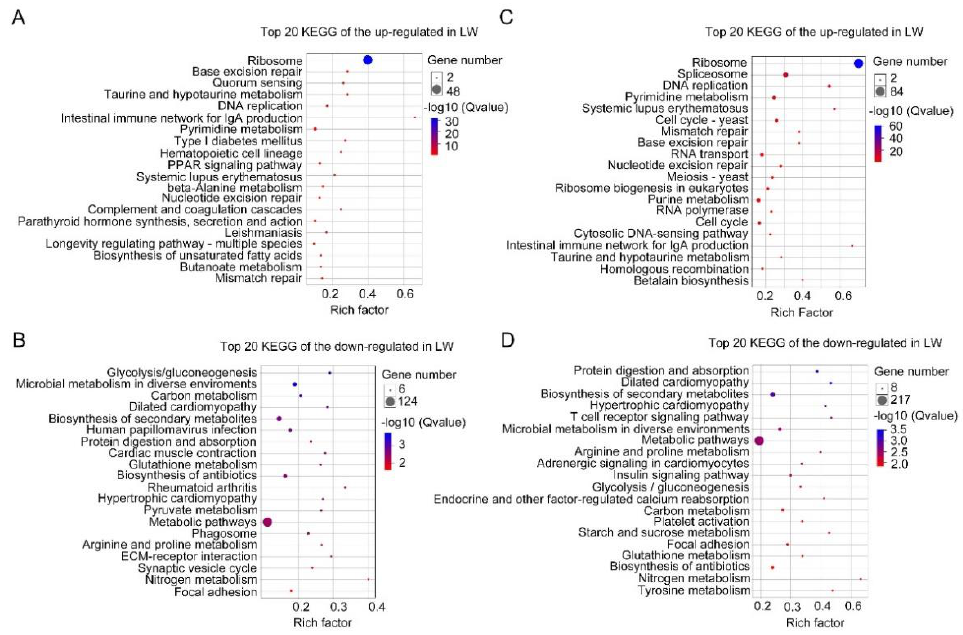
Figure 4. Top 20 enriched KEGG pathways of DEGs in 24 hAE-5th-instar nymphs with NlFoxO and Gfp knockdown. ( A , B ) Top 20 enriched KEGG pathways of up-regulated and down-regulated genes in forewing buds, respectively. ( C , D ) Top 20 enriched KEGG pathways of up-regulated and down-regulated genes in hindwing buds, respectively. The q -values in different colors denote significant enrichment. Different sizes of dots represent the number of genes enriched in each pathway.